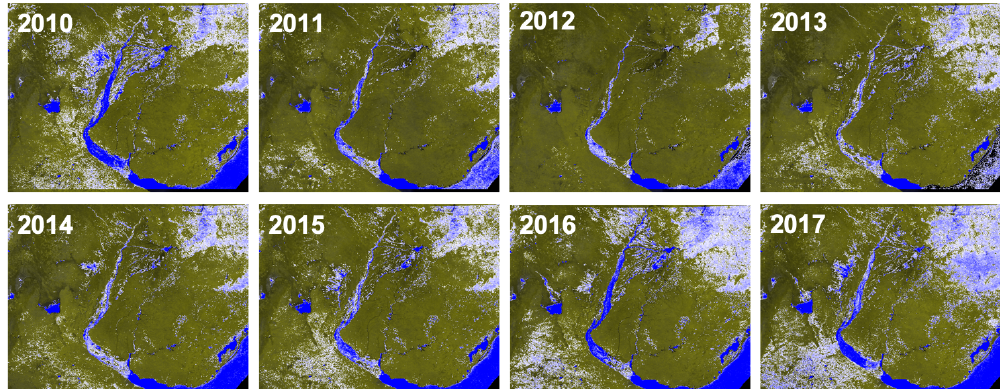
Figure 9. MODIS Normalized Difference Water Index (NDWI) indicating surface water extent for November–April from 2010 to 2017 overlaid onto MODIS RGB imagery for the Paraná